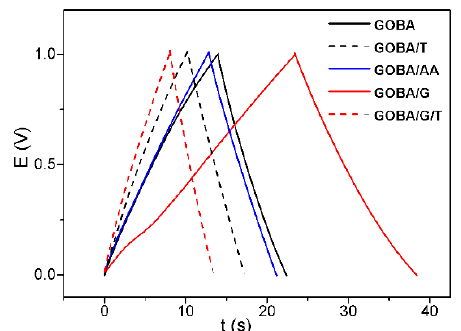
Figure 6. Charge discharge curves at the rGO electrodes: applied current 1.2 mA, electrolyte 0.1 M K 2 SO 4 , material load 2.4 mg.